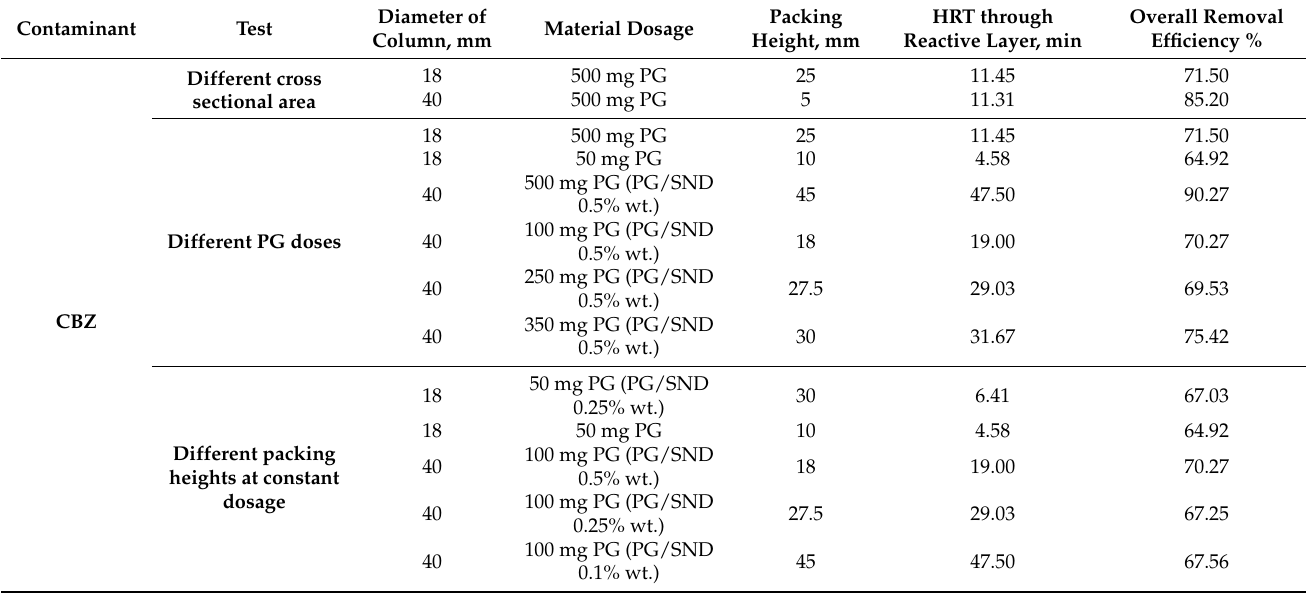
Table 2. Hydraulic retention time and overall removal efficiency of CBZ removal by column filters of different cross sectional areas, PG doses, and packing heights at constant dosage. Experimental conditions: ECs-contaminated DW influent adjusted at 10.5 mg/L of EC; room temperature at 22 ± 3 ◦ C.